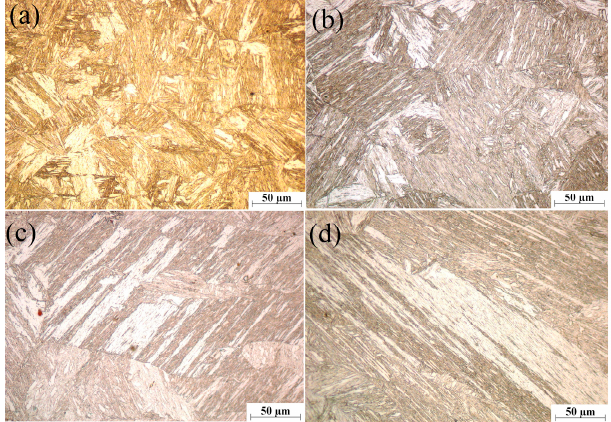
Figure 15. The microstructures of welding joints with different dwell periods above Ac1 : ( a ) 156 ms; ( b ) 234 ms; ( c ) 256 ms; and ( d ) 267 ms.